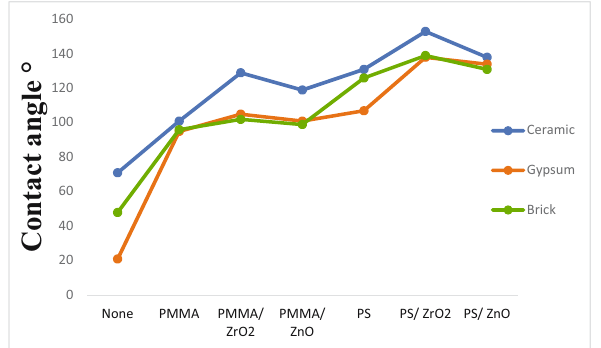
Figure 2: CA results for di ff erent coated surfaces.